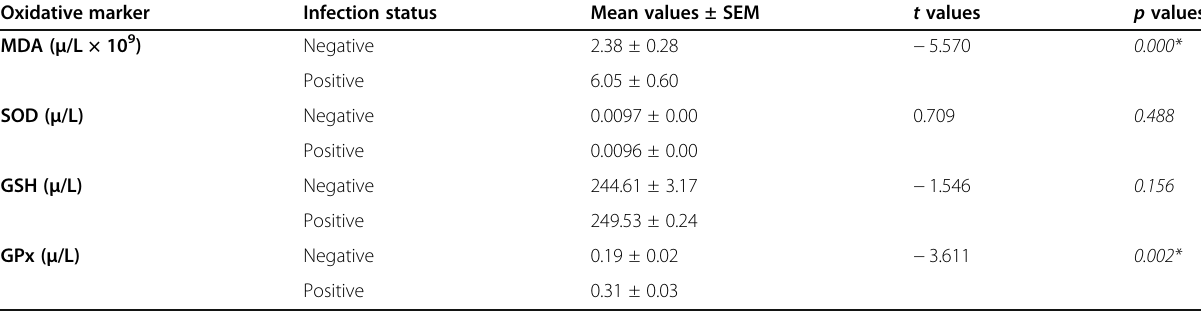
Positive 0.31 ± 0.03 *Significant difference ( p <